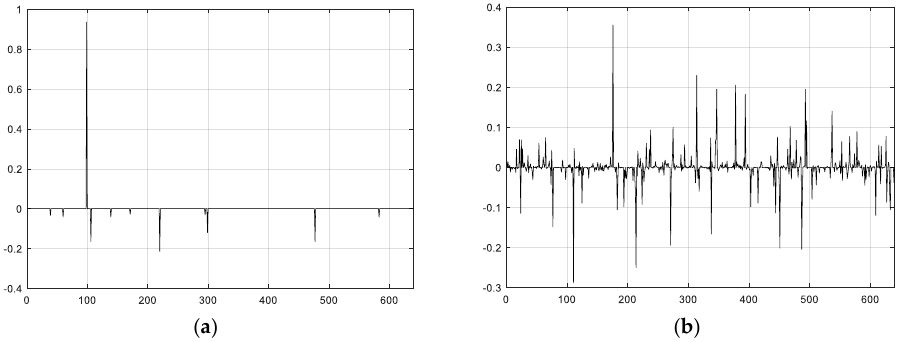
Figure 6. Wavelet functions of the second scheme: ( a ) First-level wavelet function; ( b ) 10th-level wavelet function.